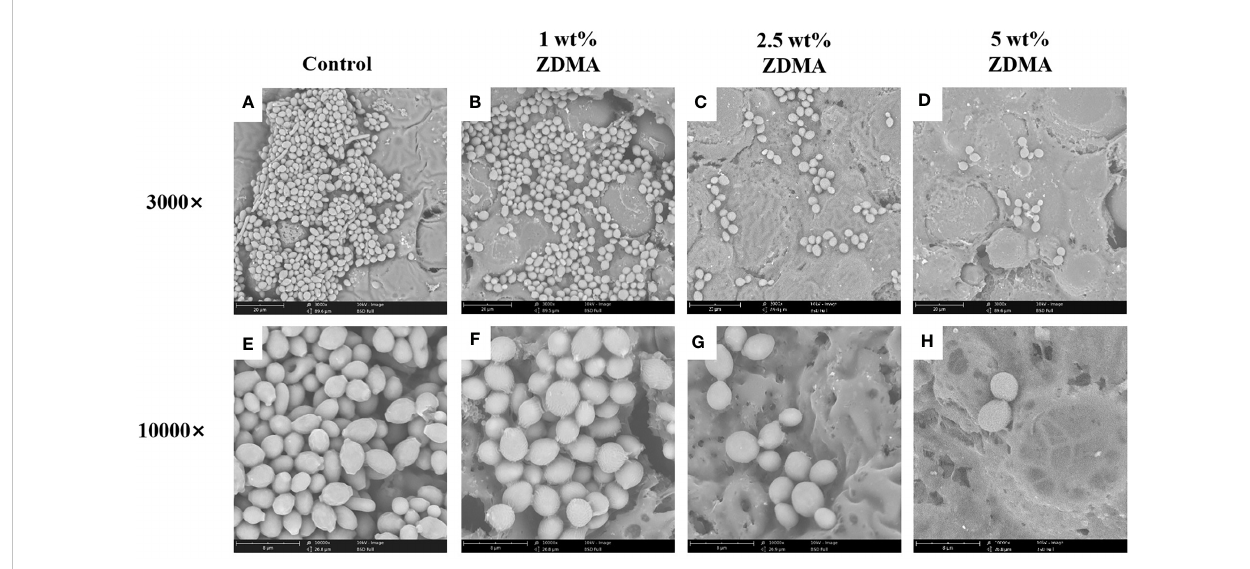
FIGURE 9 Representative scanning electron microscopy images showing morphologic changes of C. albicans on the specimens of each group: Images